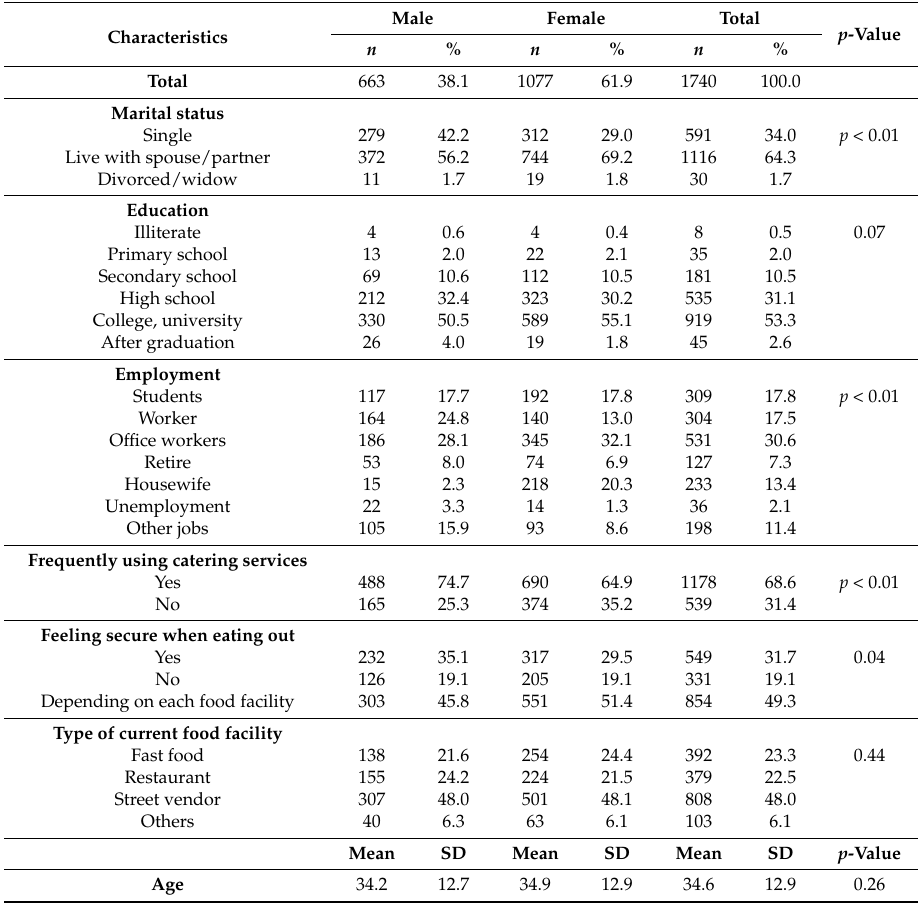
Table 1. Socioeconomic characteristics of respondents.